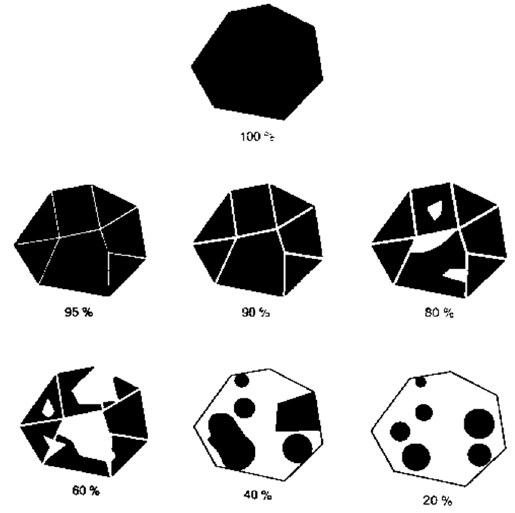
Figure 2. Visual references to evaluate degree of bitumen coverage.